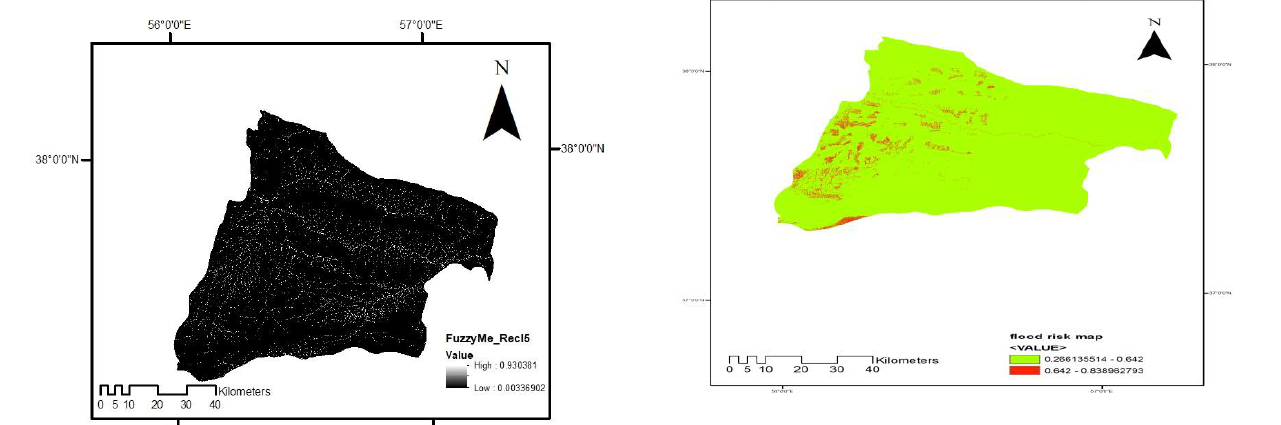
Figure 11. Flood risk map with 95%